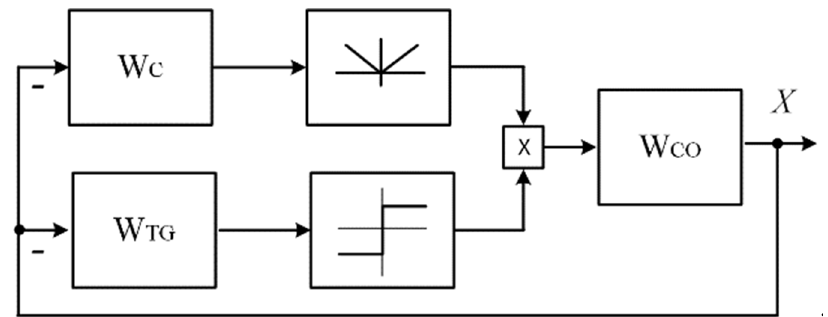
Figure 7. Block diagram of a system with a variable structure regulator (VSR).